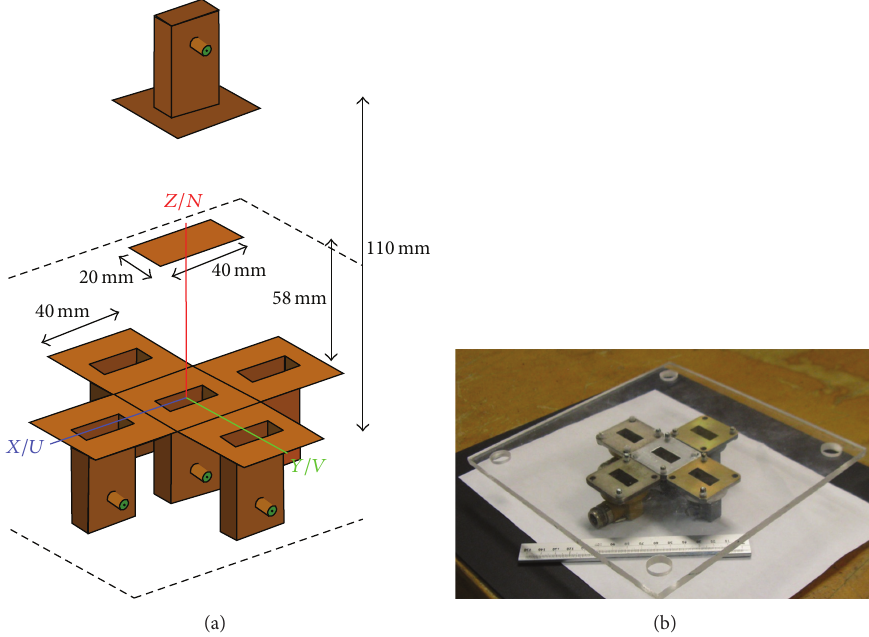
Figure 12: (a) Illustration of the experimental imaging setup consisting of six X-band open-ended waveguides where one acts as a transmitter and five act as receivers. A rectangular metallic sheet is being imaged. (b) Image of five open-ended waveguides attached together to construct the multiple receiver array.